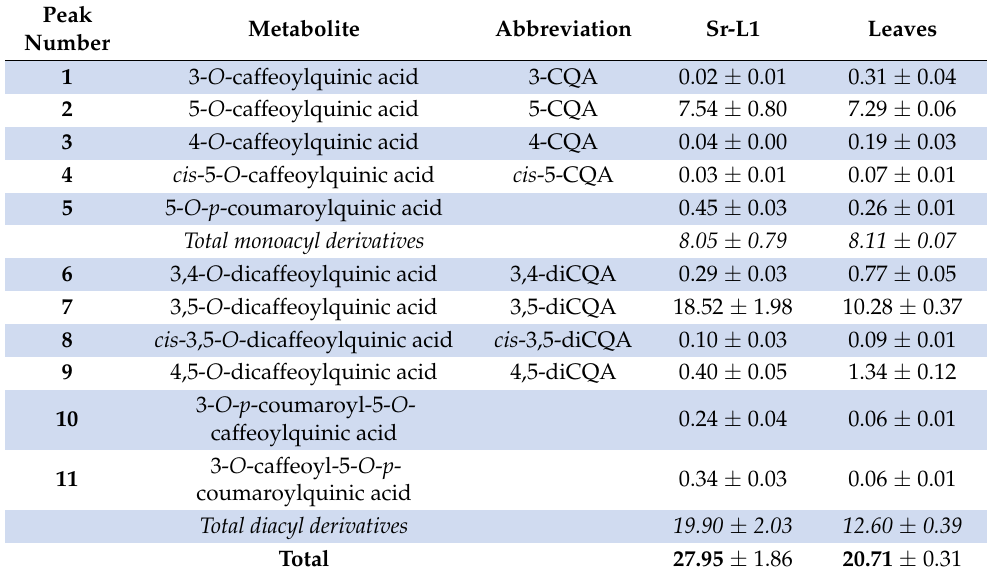
Table 2. Content of CQA derivatives (mg/g dry weight ± SE) in the callus line Sr-L1 and leaves of S. radiate. Results were obtained as an average of ten biological samples from different passages for callus line and three biological samples for leaves, with three analytical replicates